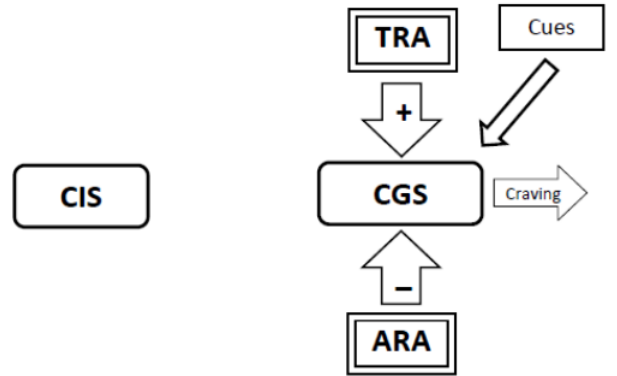
Figure 8. At any time cues could trigger minor craving by directly stimulating the Craving Generation System (CGS). The smoker might lapse by smoking a single cigarette.